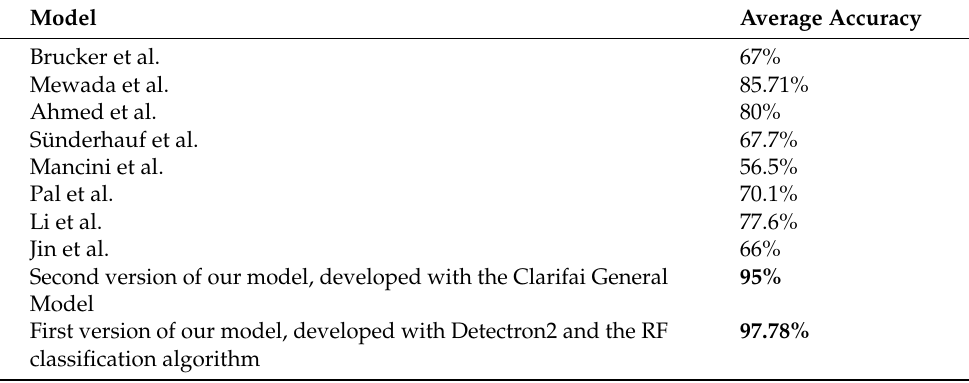
Table 21. Comparison of model performances in terms of average accuracy. Model Average Accuracy Brucker et